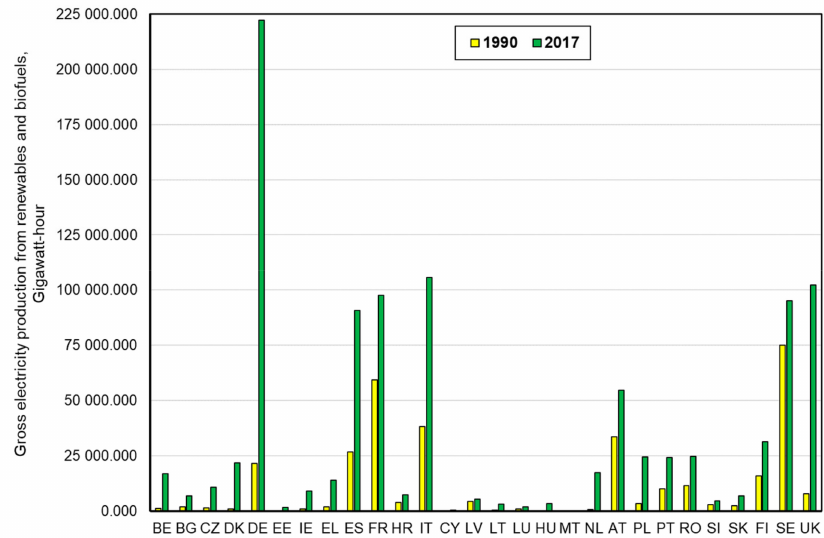
Figure3. ComparisonofenergyproductionfromrenewableenergysourcesinindividualEUcountriesin